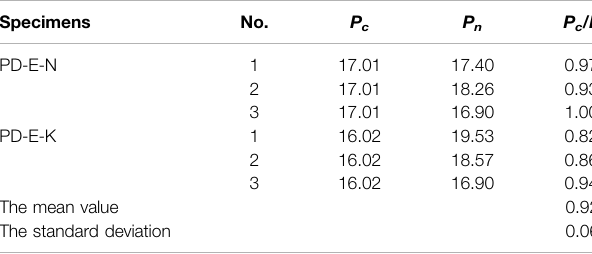
TABLE 5 | Comparison between calculated and experimental values.